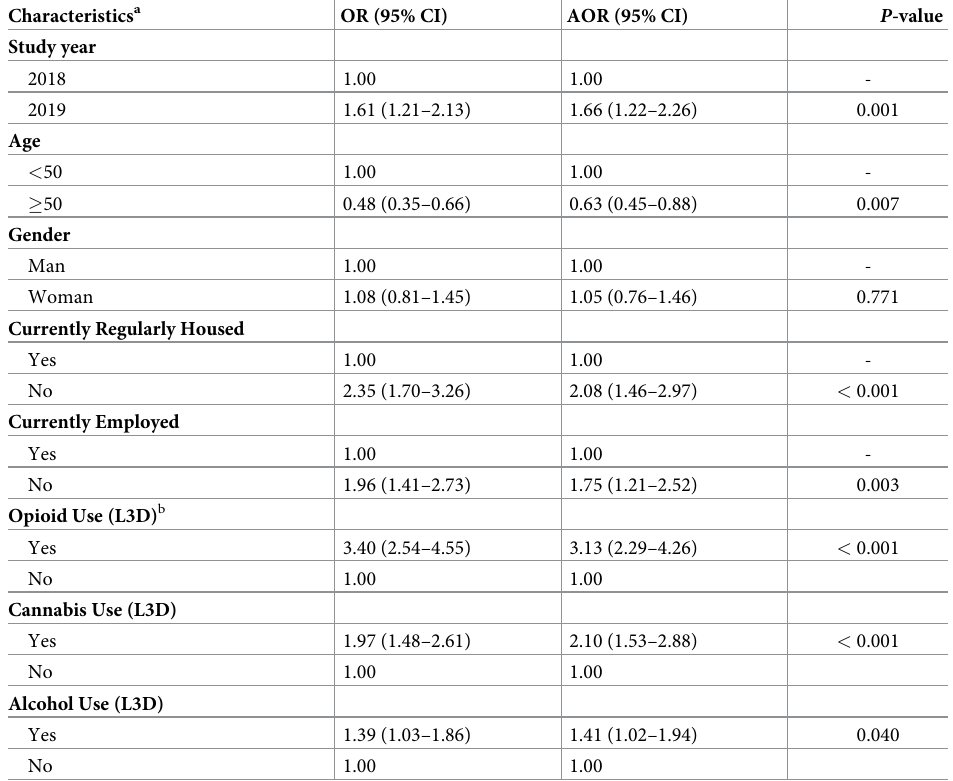
Table 3. Unadjusted and adjusted odds ratios and 95% confidence intervals for factors associated with past three- day self-reported crystal meth use (N =